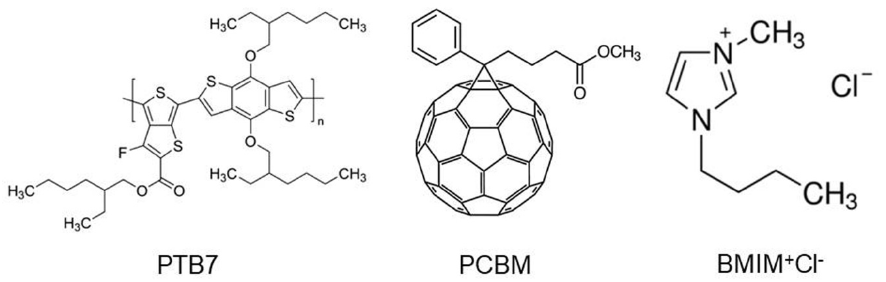
Figure 1. Molecular structure of PTB7, PCBM, and BMIM + Cl − .